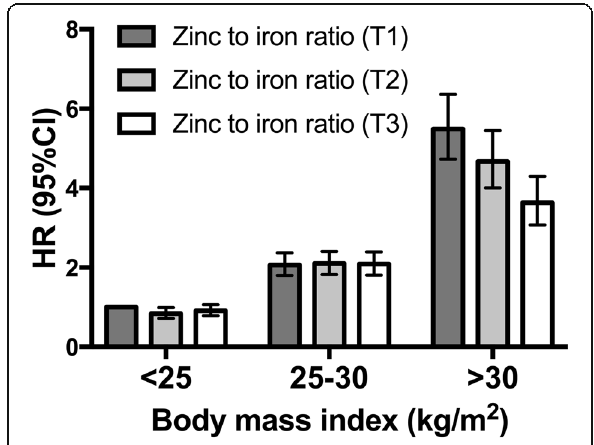
Fig. 3 Tertiles of zinc to iron ratio and risk of T2D across categories of BMI in the MDCS ( n = 26,132). Hazard ratios (HR) from a Cox proportional hazards model adjusting for dietary and non-dietary confounders. P interaction (zinc to iron ratio × BMI) = 0.005